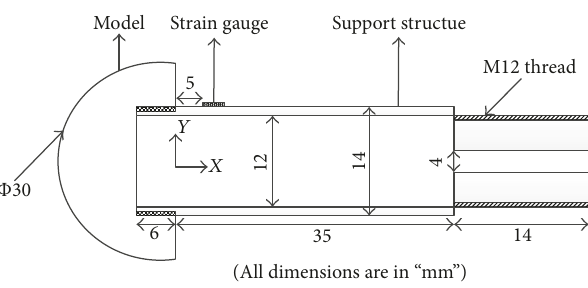
Figure 7: Schematic drawing of the hemispherical